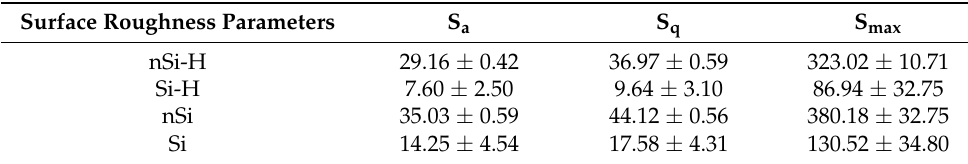
Table 1. Surface roughness parameters as determined by AFM analysis. Surface Roughness